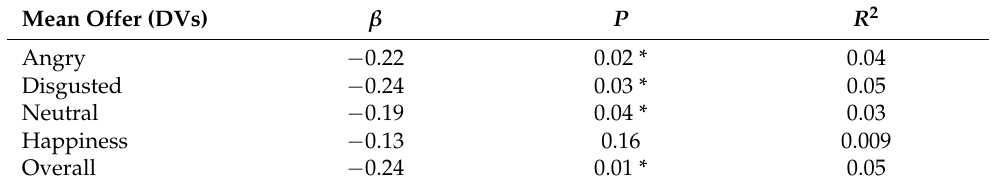
Table 3. Regression results: LoM as a continuous predictor and angry, disgusted, neutral, happy and overall average offer as DVs. Asterisks (*) indicate significant post hoc comparisons. Mean Offer (DVs)